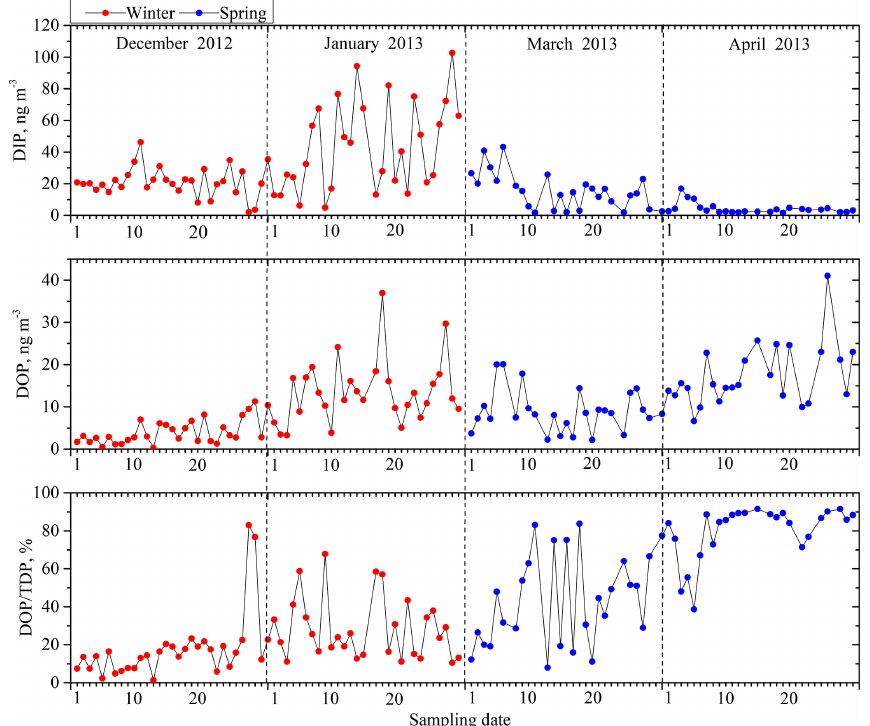
Figure 2. Time series of dissolved inorganic and organic P concentrations (DIP and DOP) and the percentage of DOP in TDP.